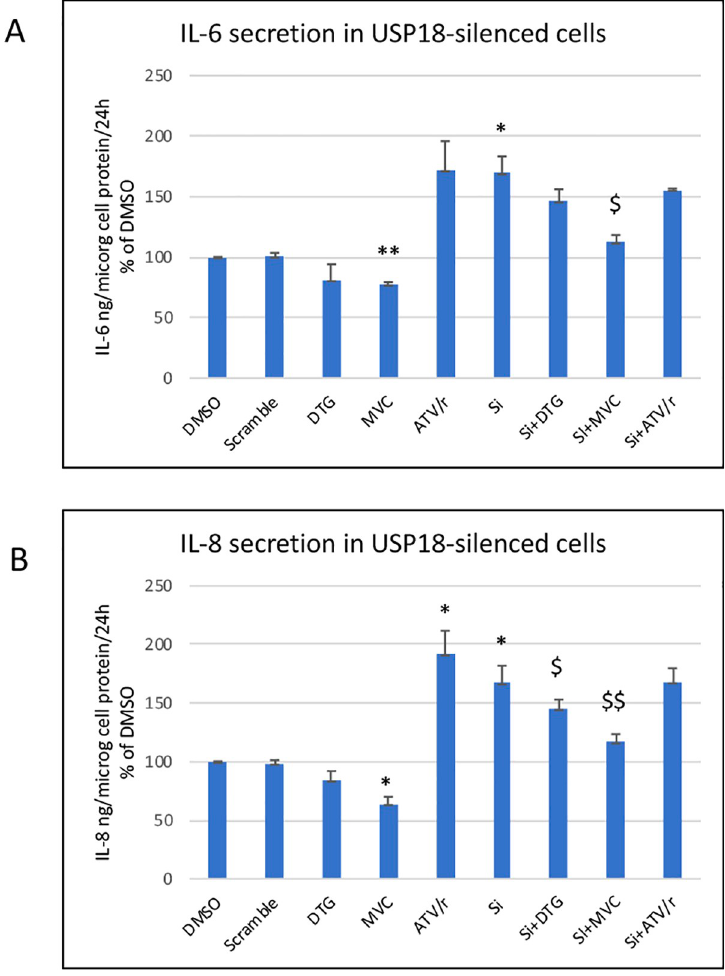
Fig 6. Effect of USP18 silencing on the level of the IL-6 (A) and IL-8 secretion (B) The level of IL-6 and IL-8 was evaluated in the last 24-hour culture medium and reported to the total cellular protein level in each well. The histograms represent the mean+/-SEM value as compared to the DMSO control set at 100% of 4 independent experiments. Si-DMSO: control silenced for USP18, Si-DTG: DTG-treated cells silenced for USP18, Si-MVC: MVC- treated cells silenced for USP18, Si-ATV/r: ATV/r-treated cells silenced for USP18 The comparisons used Welch’s correction of Student T-test. � p < 0.05, �� p < 0.01 versus control (DMSO) $ p < 0.05, $ $ p < 0.01versus Si-DMSO.